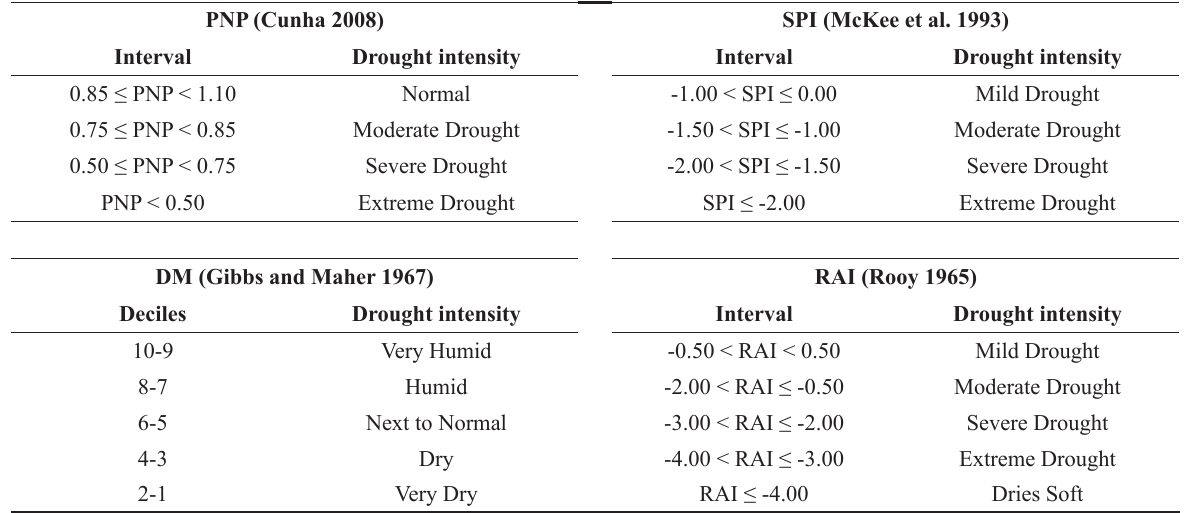
Relation between PNP, SPI, DM and RAI values and drought intensity.